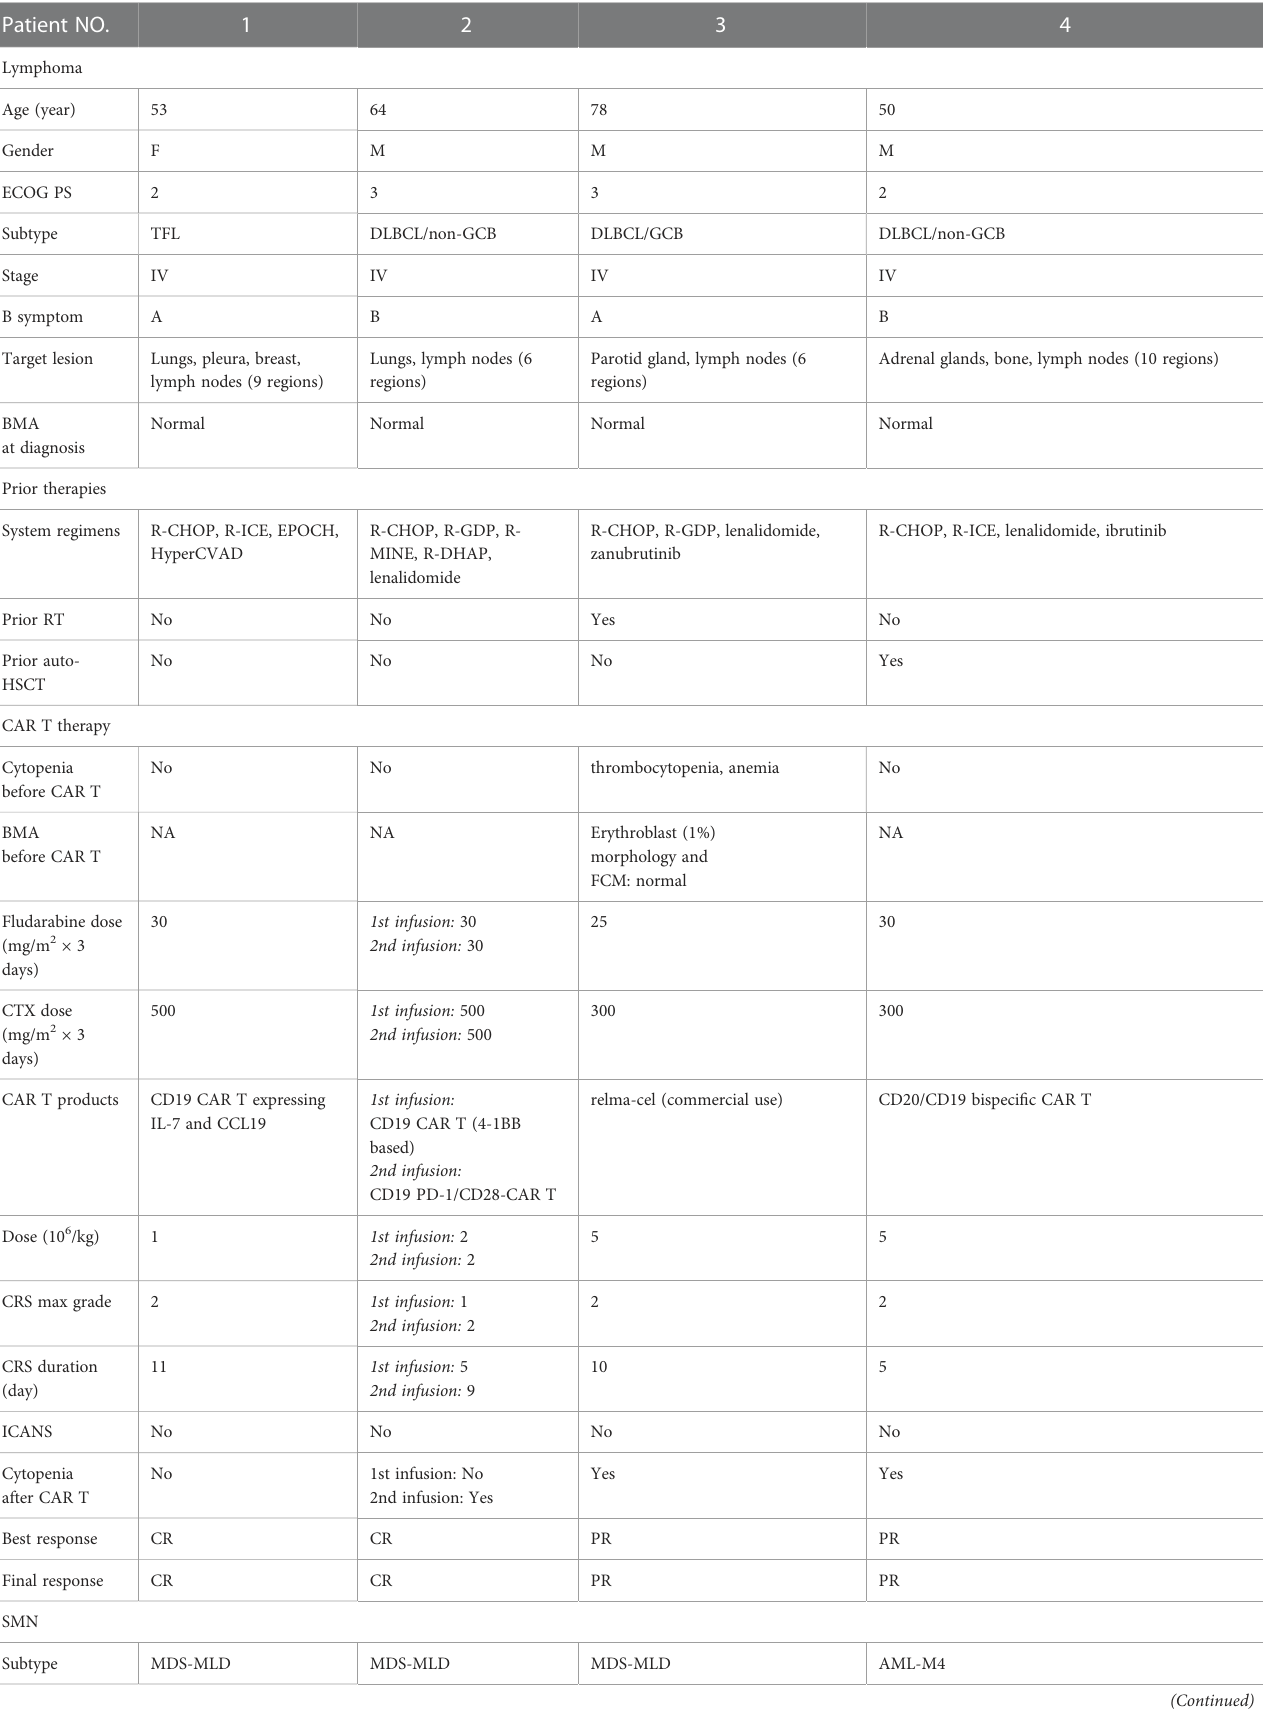
TABLE 1 New patients with SMN after CAR T therapy. Patient